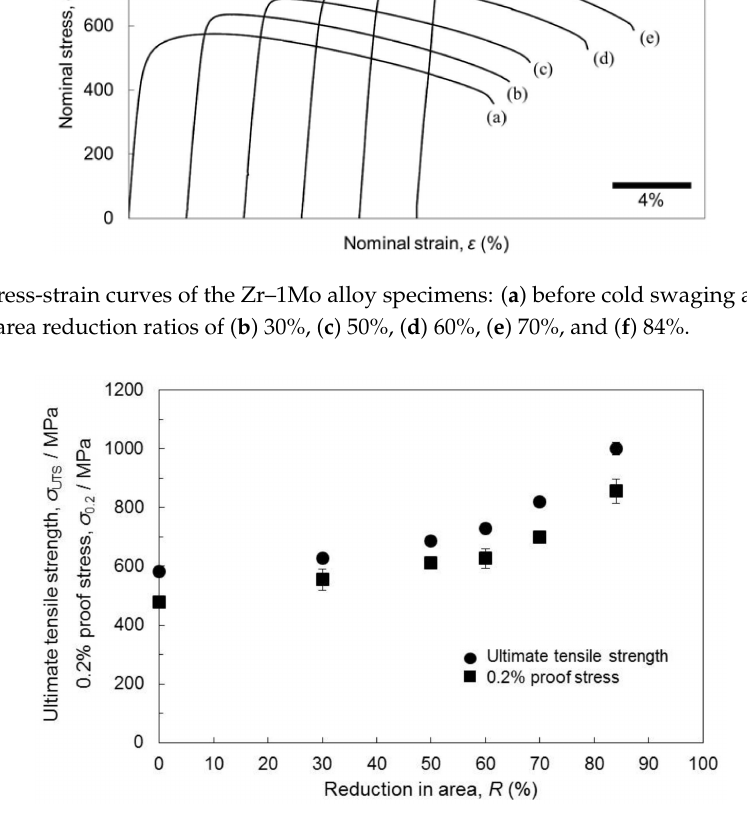
Figure 7. Ultimate tensile strengths (UTS) and 0.2% proof stress values of Zr–1Mo alloy specimens with area reductions of 0–84%.